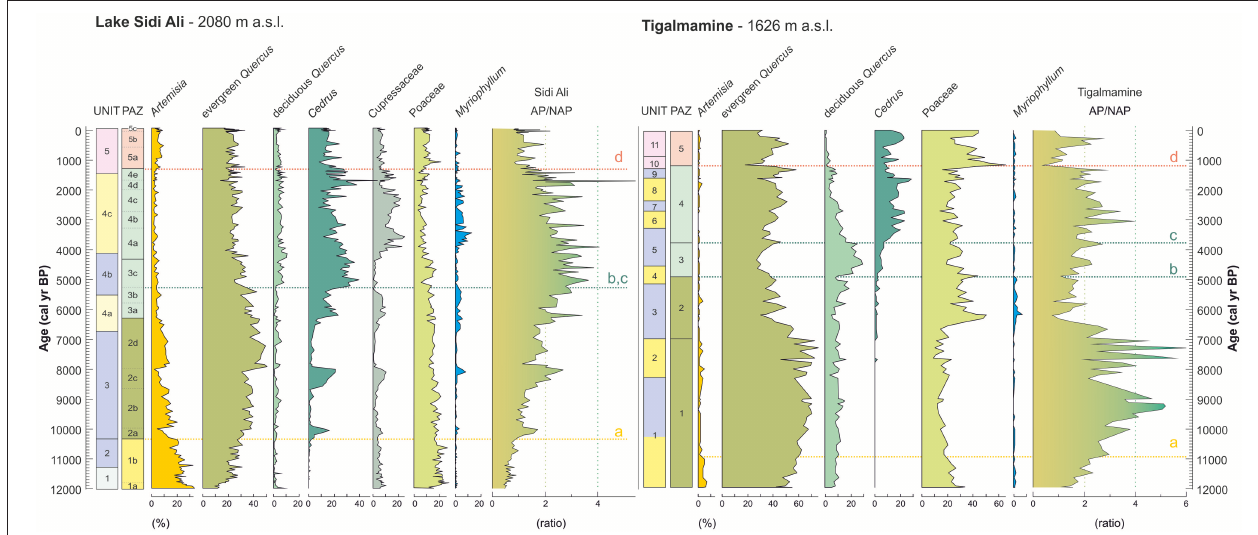
FIGURE 10 | Comparison of key pollen taxa and AP/NAP ratios for Lake Sidi Ali (this study) and Tigalmamine (Lamb and van der Kaars, 1995). Lake Sidi Ali sedimentological units color-coded according to inferred lake level and status (see key in Figure 9 ). Tigalmamine lithological units are similarly color-coded for shallow (yellow), deep-water (blue) and anthropic (red) facies following unit descriptions and interpretation in Lamb and van der Kaars (1995). PAZ labels color-coded according to the dominant vegetation: Artemisia (yellow), evergreen Quercus (olive green), deciduous Quercus and Cedrus (pale green), non-arboreal and anthropogenic indicators (red). Dashed lines highlight similar assemblage changes at both sites: (a) Early Holocene Artemisia decline and evergreen Quercus rise; (b) Mid Holocene deciduous Quercus rise; (c) transgressive Mid to Late Holocene Cedrus expansion; (d) inferred Late Holocene anthropogenic forest decline.